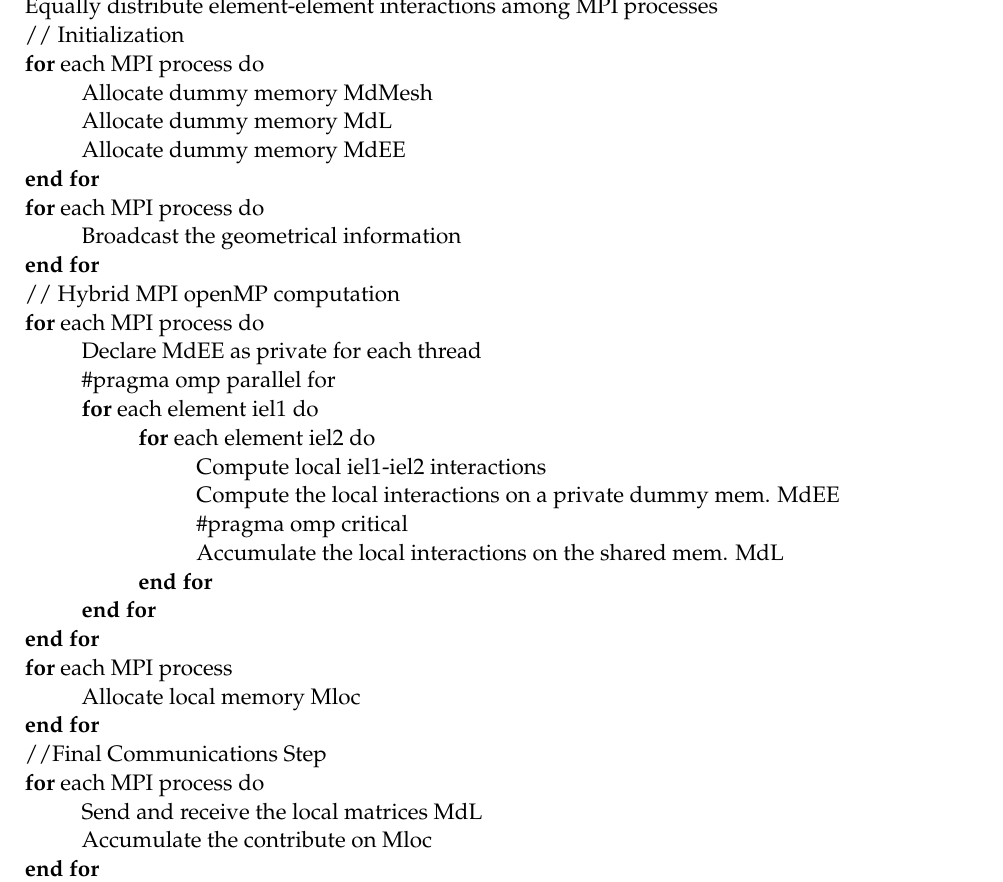
Algorithm 5 Assembly of L matrix, hybrid OpenMP-MPI